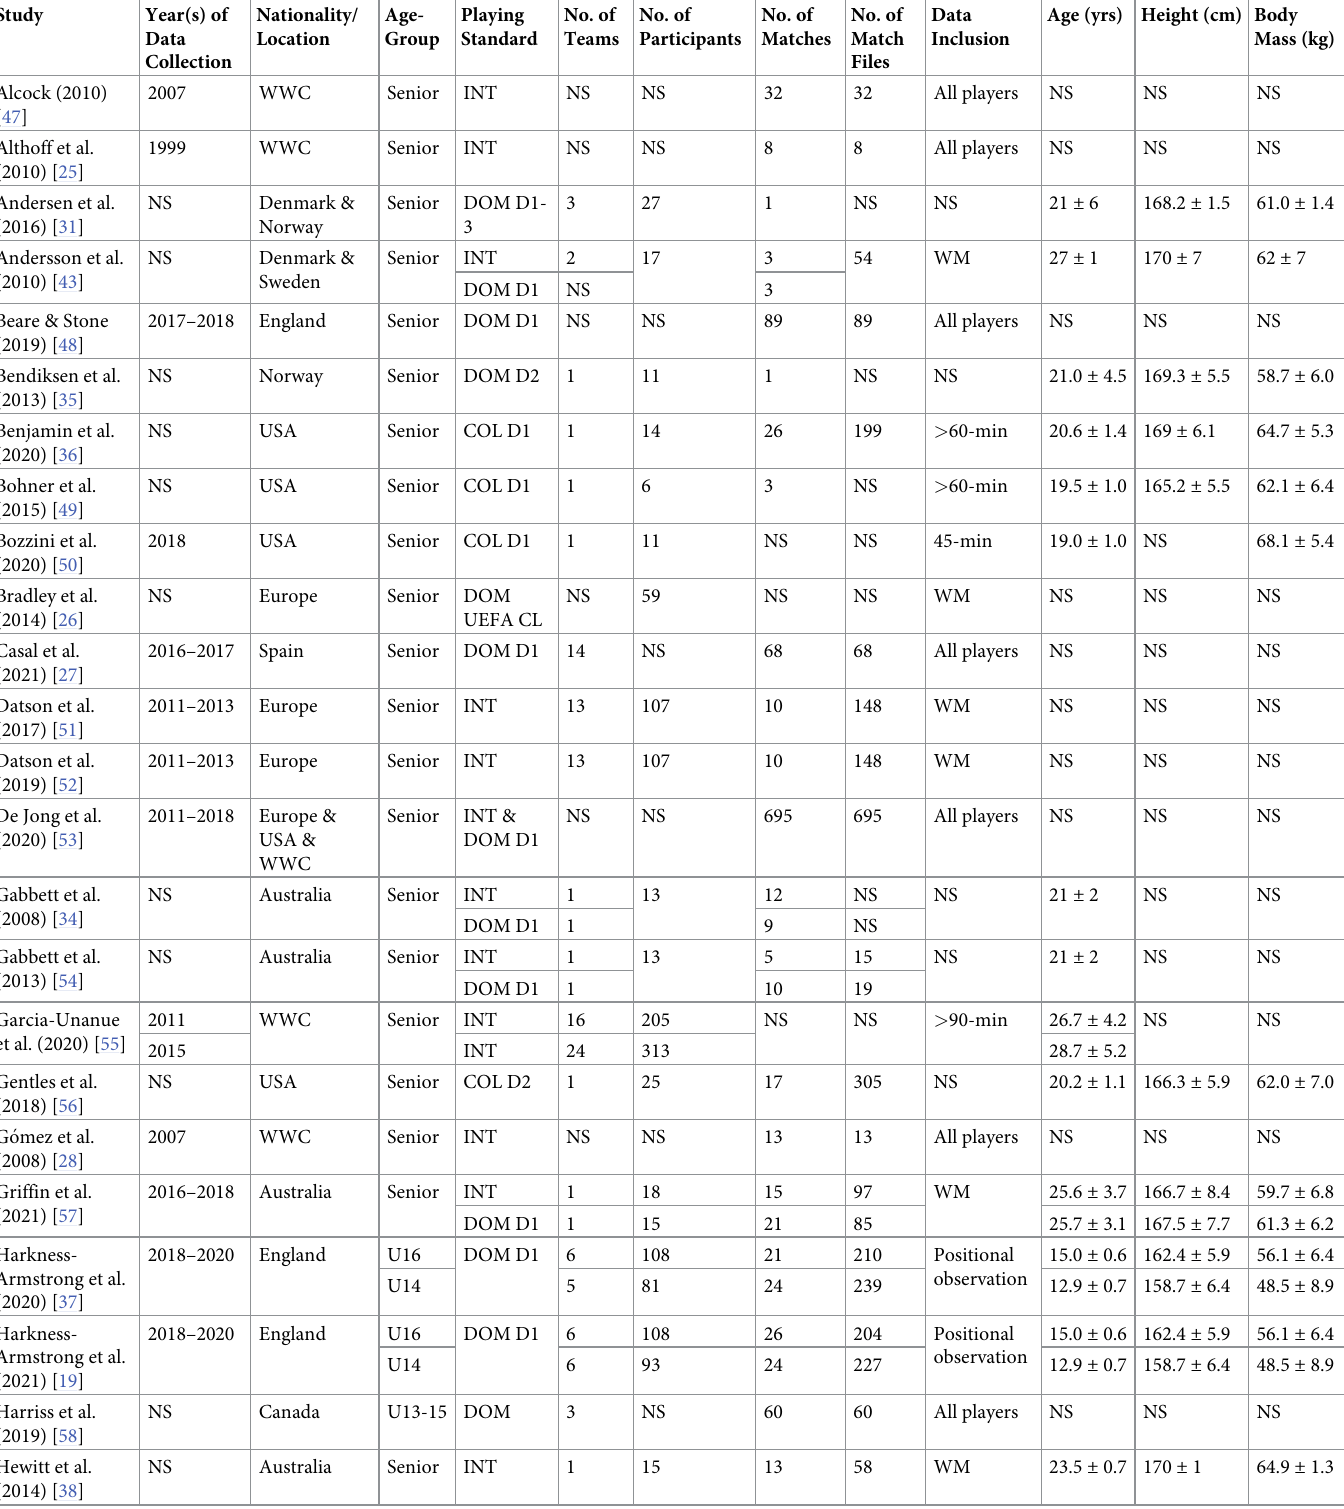
Table 3. Participant and study characteristics of studies quantifying match-play characteristics of women’s